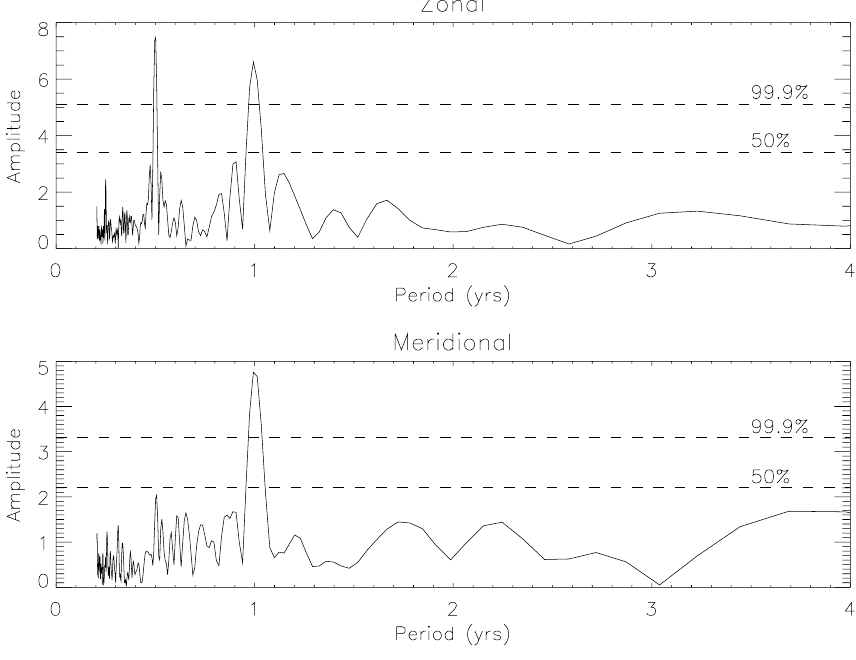
Fig. 11. Lomb periodogram of the monthly-mean winds, 1988–2000. Confidence levels of 50% and 99.9% are